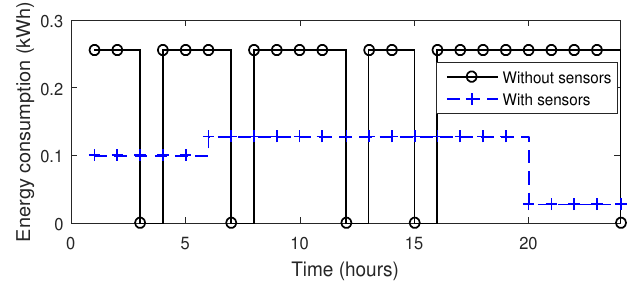
Figure 13. Energy consumption of ua appliances.